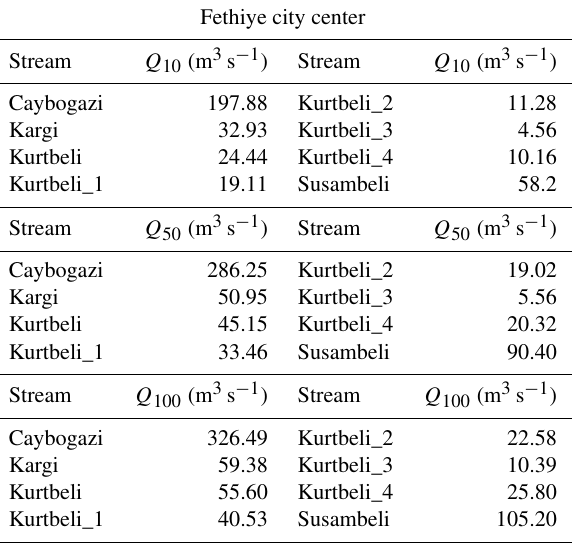
Table 1. Peak discharges of the streams for discharge of 10-year recurrence interval in the study area (SYGM,